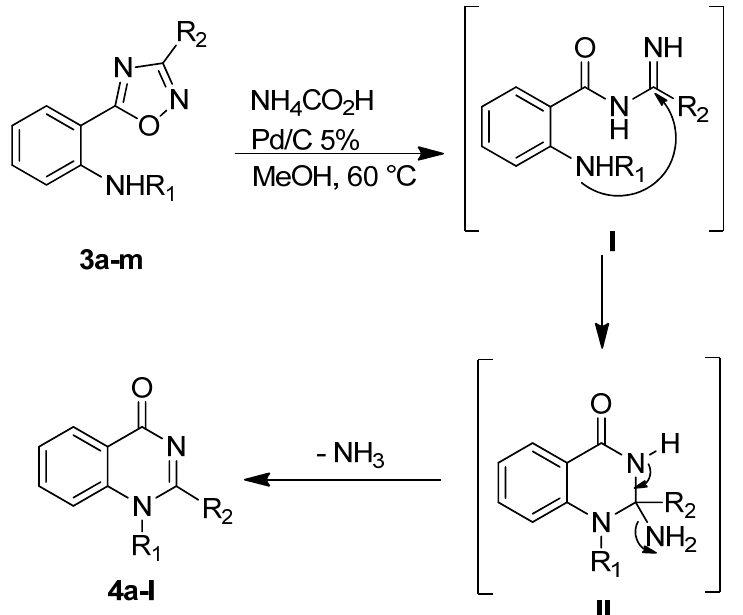
Figure 1. Representative curves of the dipeptidyl peptidase activity in the presence of the compounds (100 µM). Sitagliptin was used as positive control for the test. Fluorescence values (RFU) were measured in kinetic mode. Data were analyzed through linear regression analysis performed for the initial points of the curve.